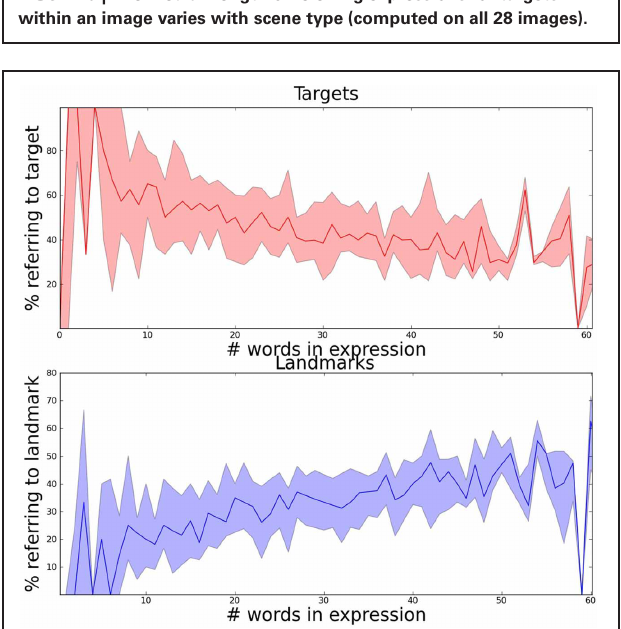
FIGURE 6 | Longer referring expressions have proportionally fewer words describing the target (top plot shows median and quartiles) and proportionally more words describing other objects (bottom plot shows median and